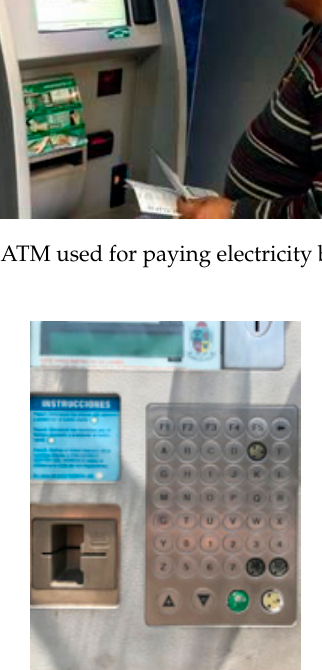
Figure 29. Interface of parking meter in San Pedro Garza Garc í a. The keyboard is in alphabetical order. Figure 28. Interface of parking meter in San Pedro Garza García. The keyboard is in alphabetical Users expect a QWERTY keyboard order. Users expect a QWERTY keyboard layout.